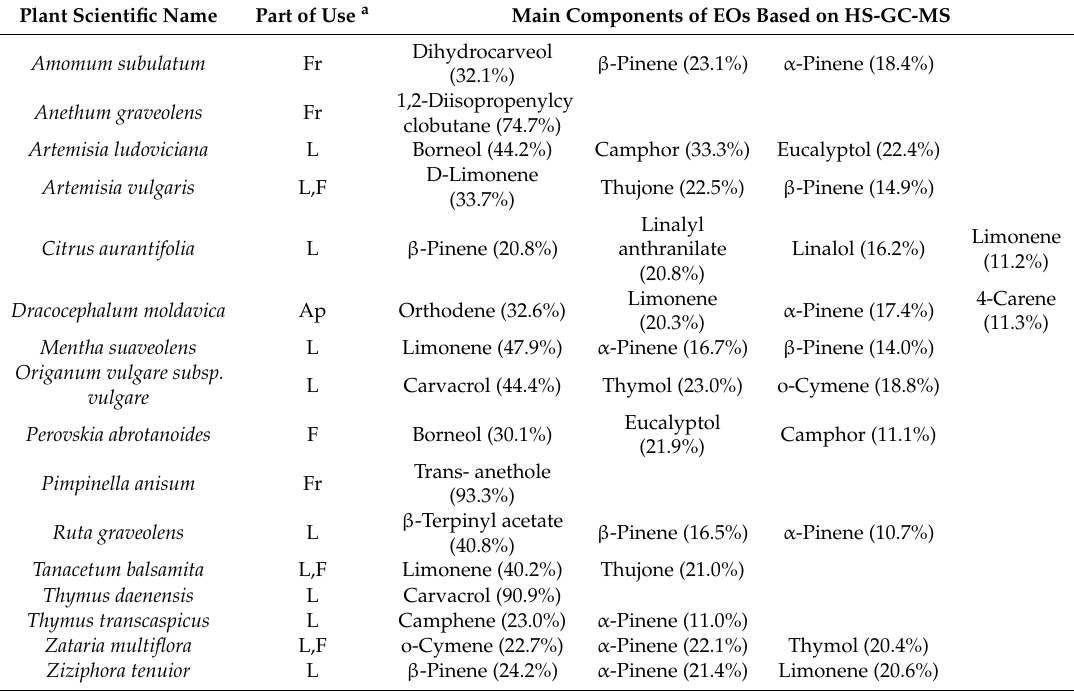
Table 2. The main components of EOs based on Headspace Gas Chromatography-Mass Spectrometry (HS-GC-MS)